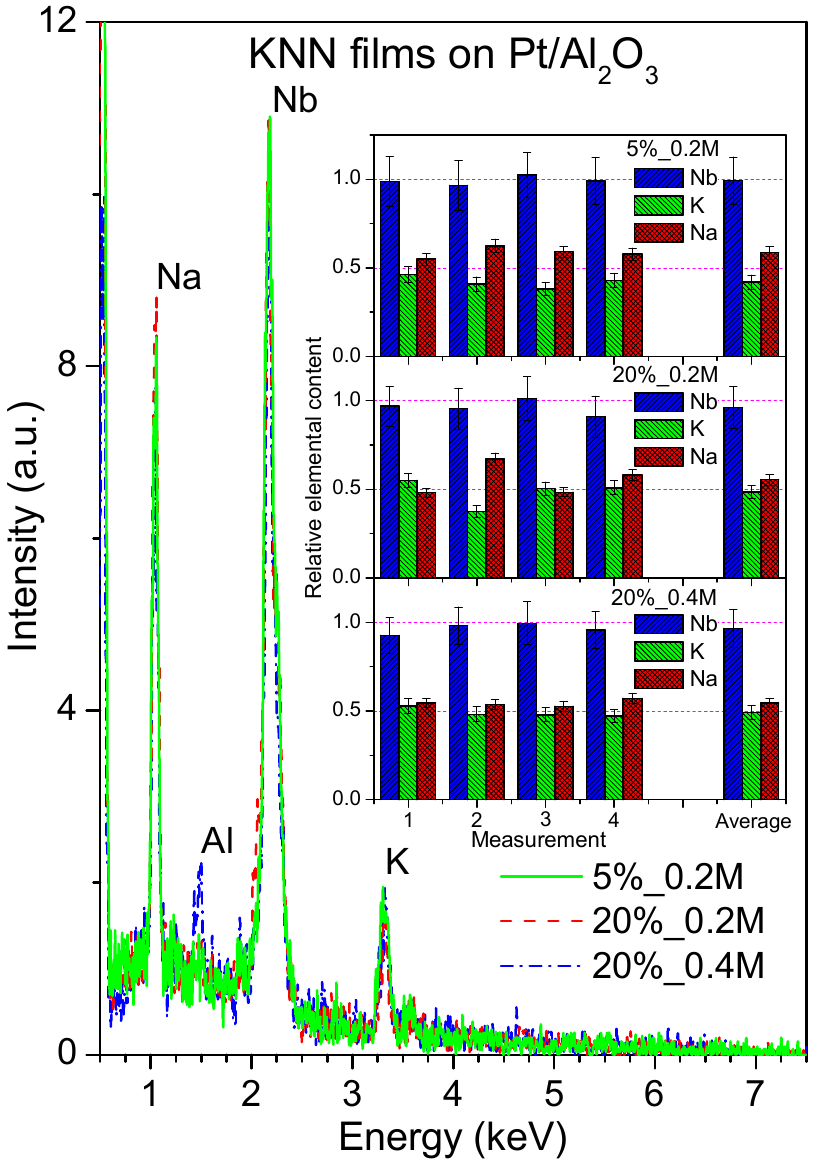
Figure 2. Energy-dispersive spectra of KNN films deposited on platinized Al 2 O 3 from solutions with 5% potassium excess and 0.2 M concentration, 20% alkali excess and 0.2 M concentration, and 20% alkali excess and 0.4 M concentration. Inset shows relative elemental content of Nb, K, and Na obtained by the spectra analysis in the 4 representative spots and in average.